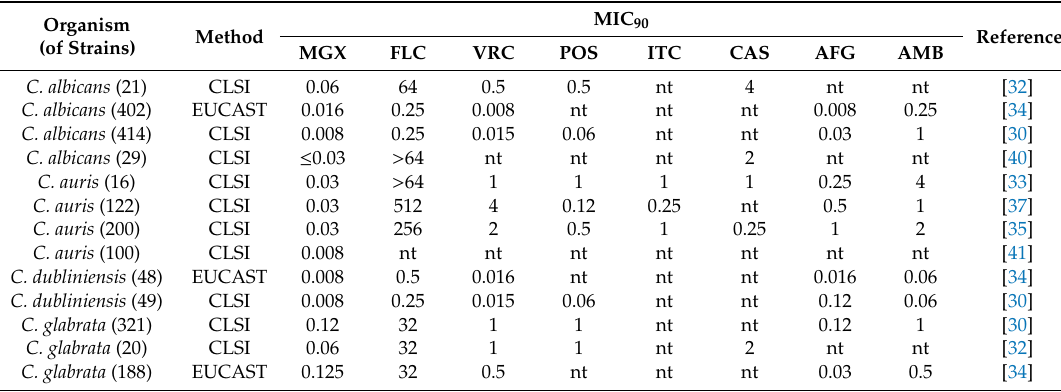
Table 1. Summary of the in vitro activity of MGX against